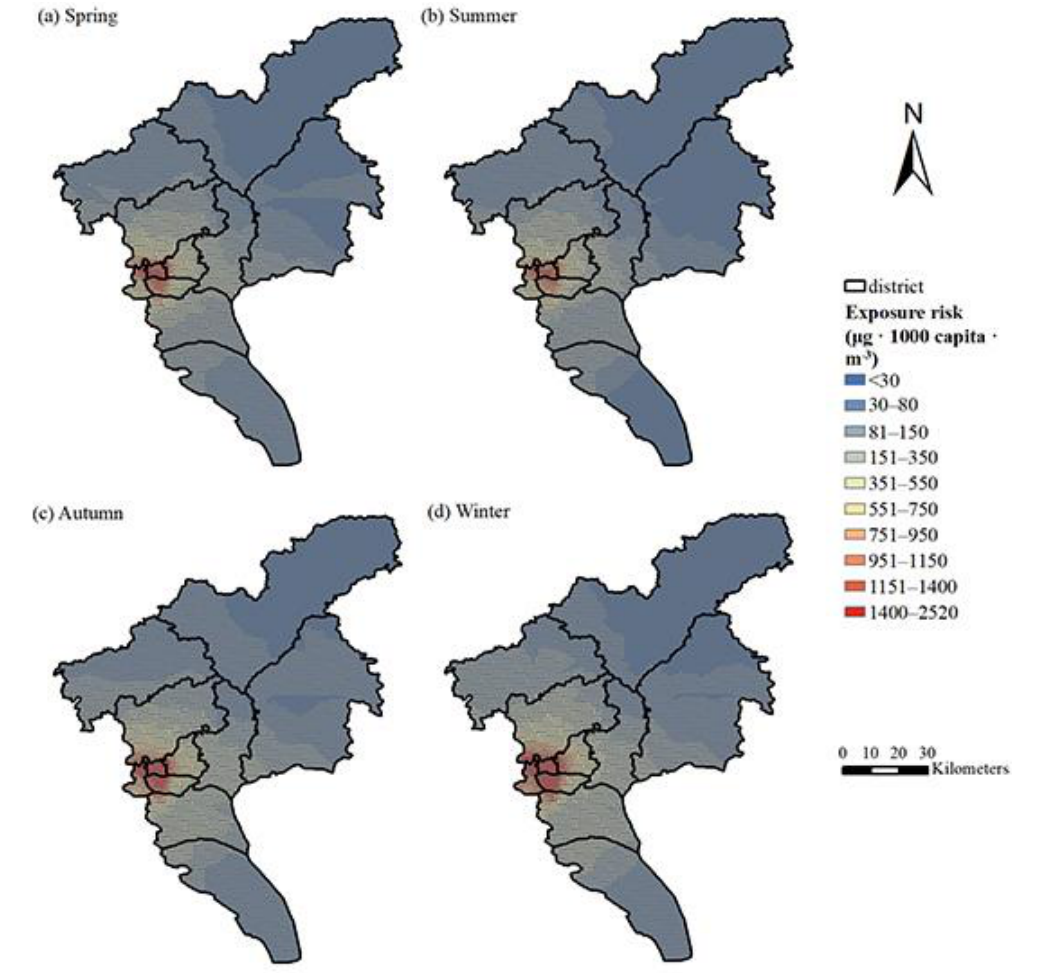
Figure 5. Exposure risk of PM 2.5 in Guangzhou across the four seasons of 2015: ( a ) spring; ( b ) summer; ( c ) autumn; ( d ) winter.